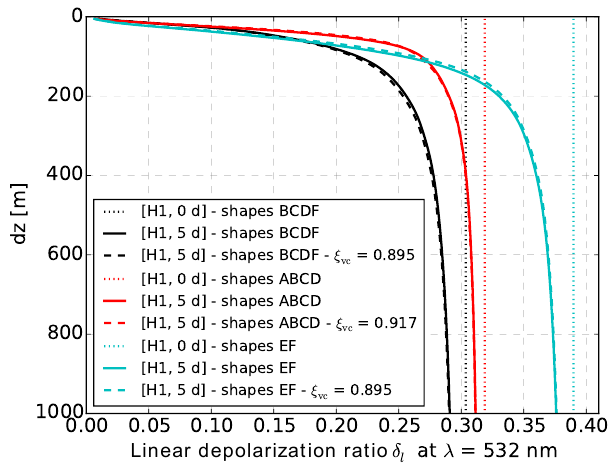
Figure 7. Linear depolarization ratio δ l profiles at λ = 532nm in the upper 1km of the SAL for both hypotheses after different transport time